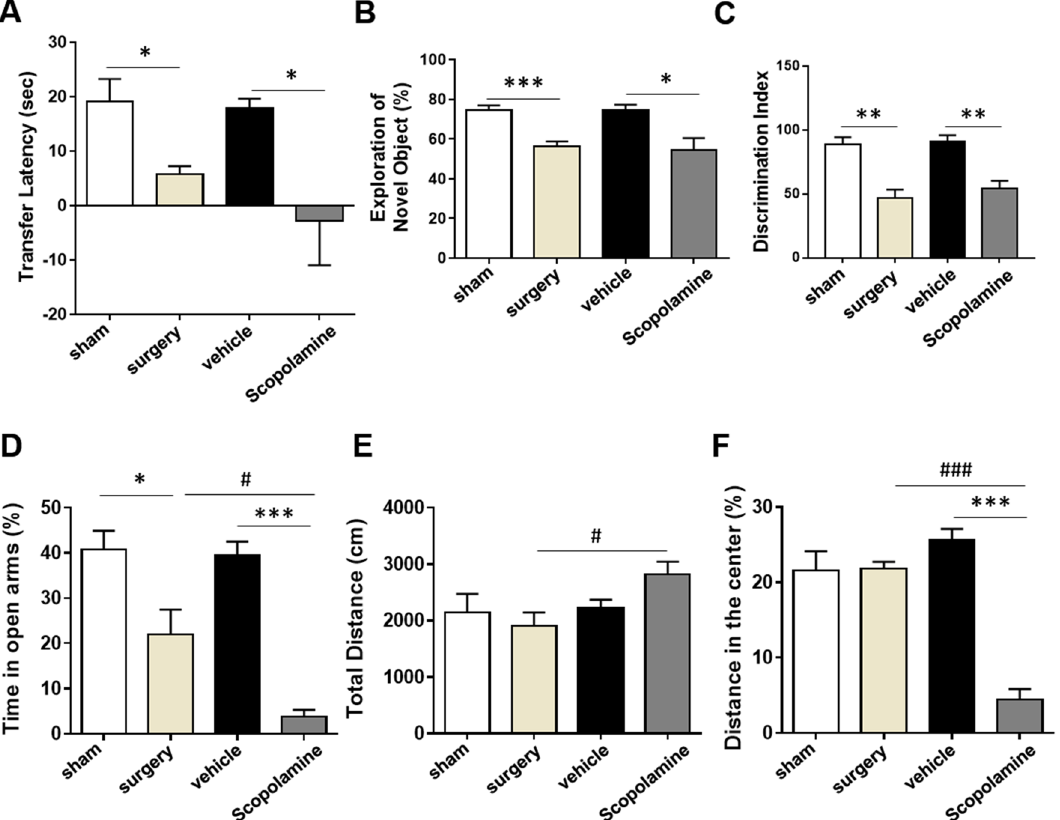
Figure 2. Effects of scopolamine on memory dysfunction and psychological behaviors in post-behavioral tests. ( A ) Changes in learning and memory is presented as the transfer latency (sec) in EPM, ( B ) the exploration time of novel object in NORT after surgery or scopolamine treatment, and ( C ) discrimination index in NORT after surgery or scopolamine treatment. ( D ) Reduced percentage time in open arms after surgery or scopolamine treatment in EPM. ( E ) Increased total distance travelled in OFT after surgery or scopolamine treatment. ( F ) Lower distance travelled in center zone of OFT after surgery or scopolamine treatment. Values are presented as mean ± SEM (n = 4–5). p values < 0.05 were considered significant ( *p < 0.05, **p < 0.01, ***p < 0.001 vs. control (sham or vehicle), #p < 0.05, ##p < 0.01, ###p < 0.001 vs. surgery). EPM; elevated plus maze, NORT; novel object recognition test, EPM; elevated plus maze, OFT; open field